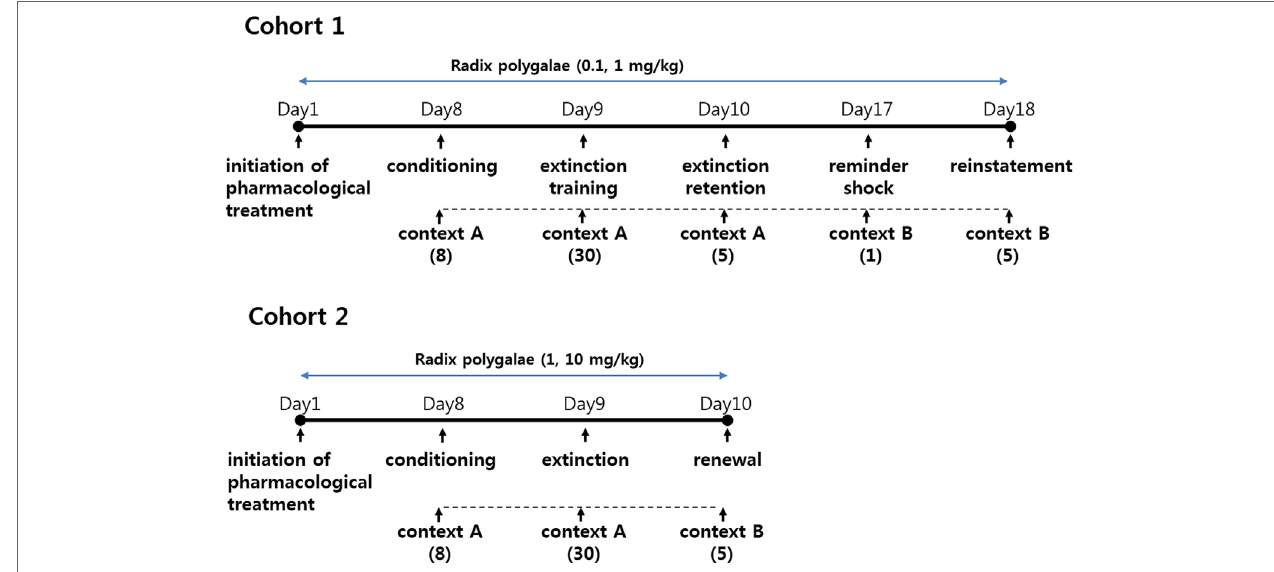
FigUre 1 | Schematic of experimental